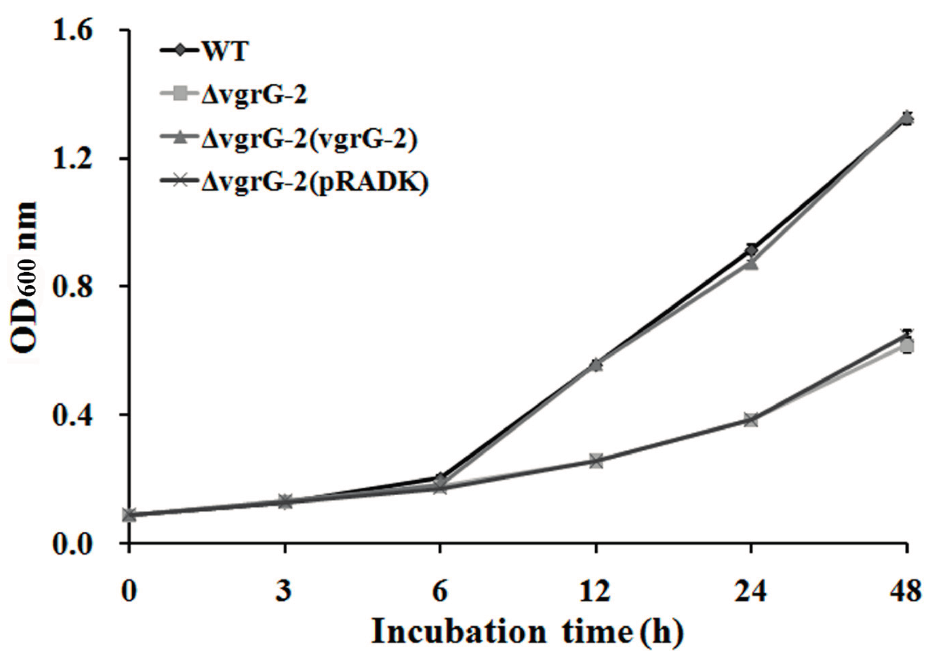
Figure 2. Comparison of growth between the wild type and Δ vgrG -2 mutant of Acidovorax avenae subsp. avenae strain RS-1. WT: wild type strain; Δ vgrG -2: vgrG -2 mutant strain; Δ vgrG -2(vgrG-2): vgrG -2 complementary strain; Δ vgrG -2(pRADK): mock strain with empty pRADK plasmid. Data from the repeated experiment were pooled and subjected to analysis of variance. Error bars represent the standard error of the mean.